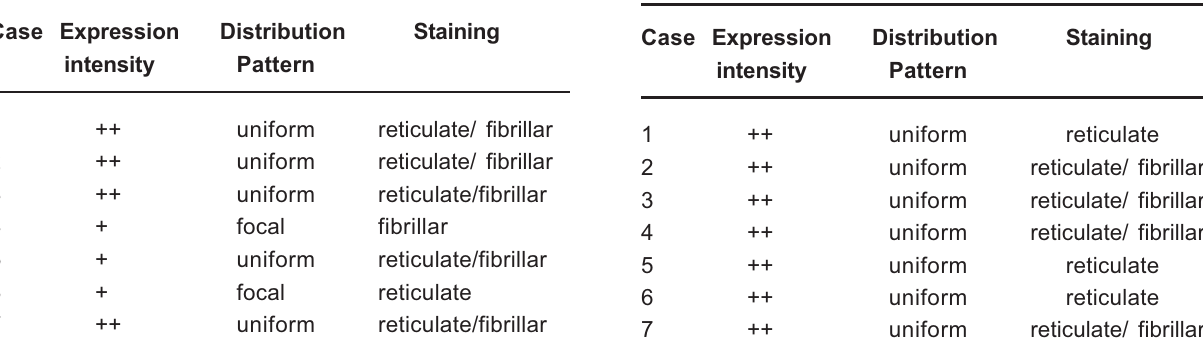
TABLE 2 - Fibronectin expression intensity, distribution and staining pattern in interstitial extracellular matrix of the giant cell tumors of long bones